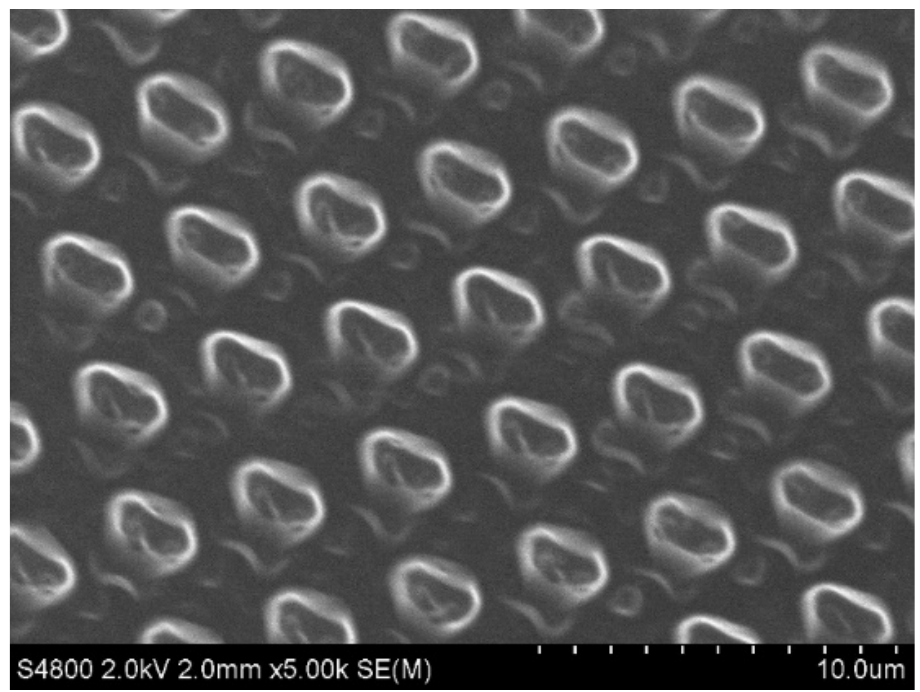
Figure 13. SEM image of the PDMS/PU (95:5) with 3 wt.% SiO 2 composite film with ridge pillar patterns.